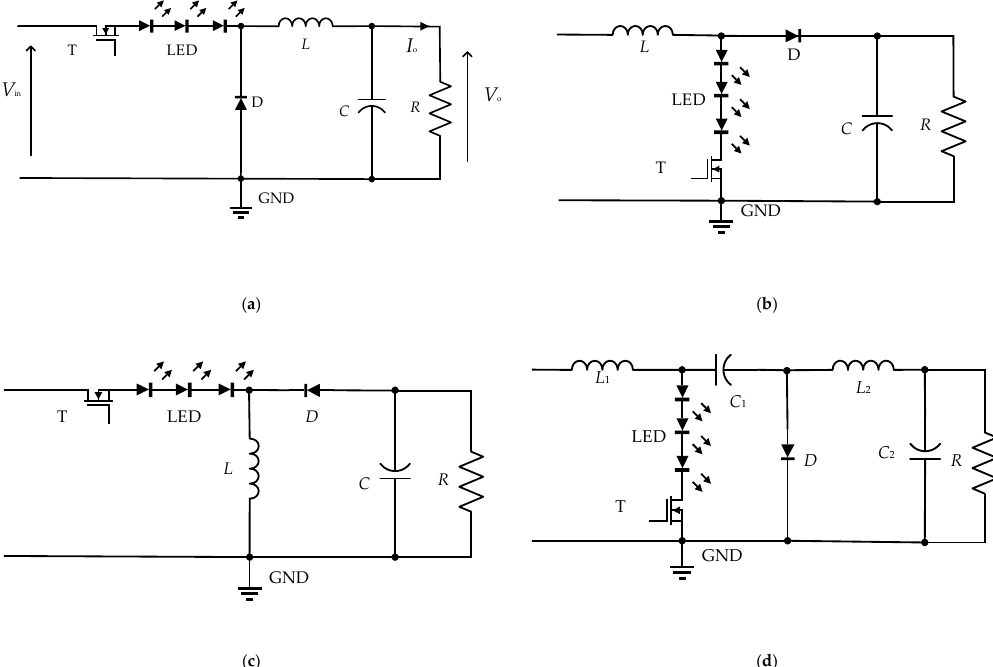
Figure 6. Transistor path LED converter. ( a ) Buck; ( b ) Boost; ( c ) Buck–Boost; ( d ) Ć uk.